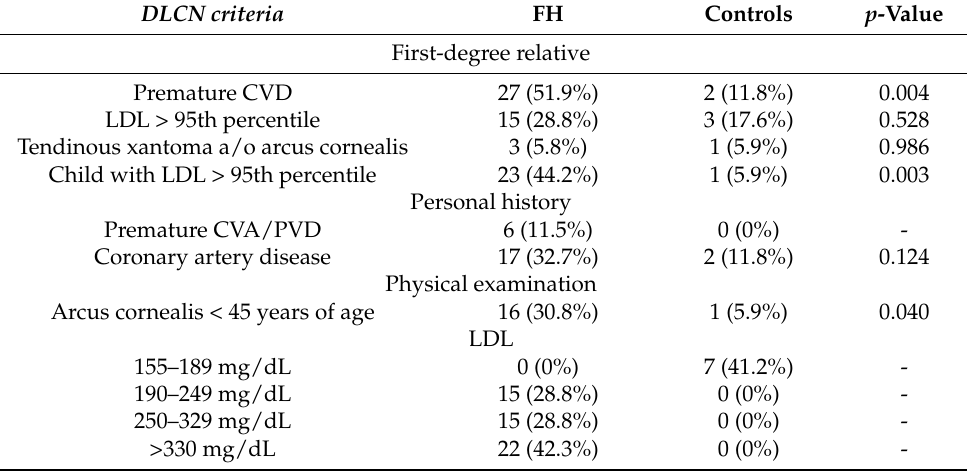
Table 2. Dutch Lipid Clinic Network diagnostic criteria applied to the studied population.